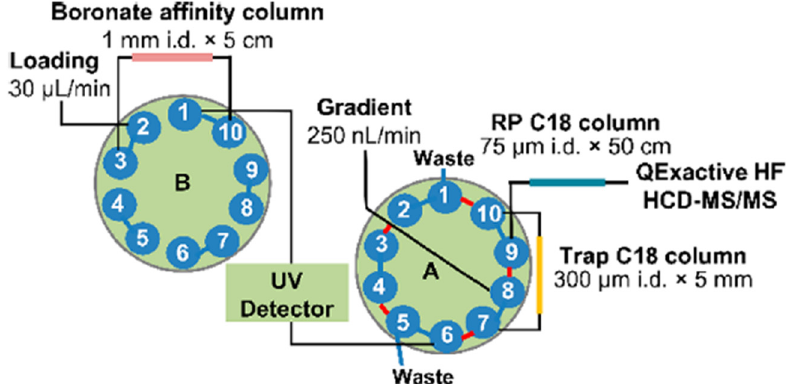
Figure 3: 2D - online LC - MS/MS using a boronic acid column for the analysis of glycated peptides. Glycated peptides are enriched on the fi rst column using BAC. The peak of the glycated peptides is detected by UV detector, and eluted glycated peptides are resolved by reversed - phase chromatography on a C18 column using a heart - cutting LC mode. Reprinted with permission from Zhang et al. [ 72 ] . Copyright 2017, American Chemical